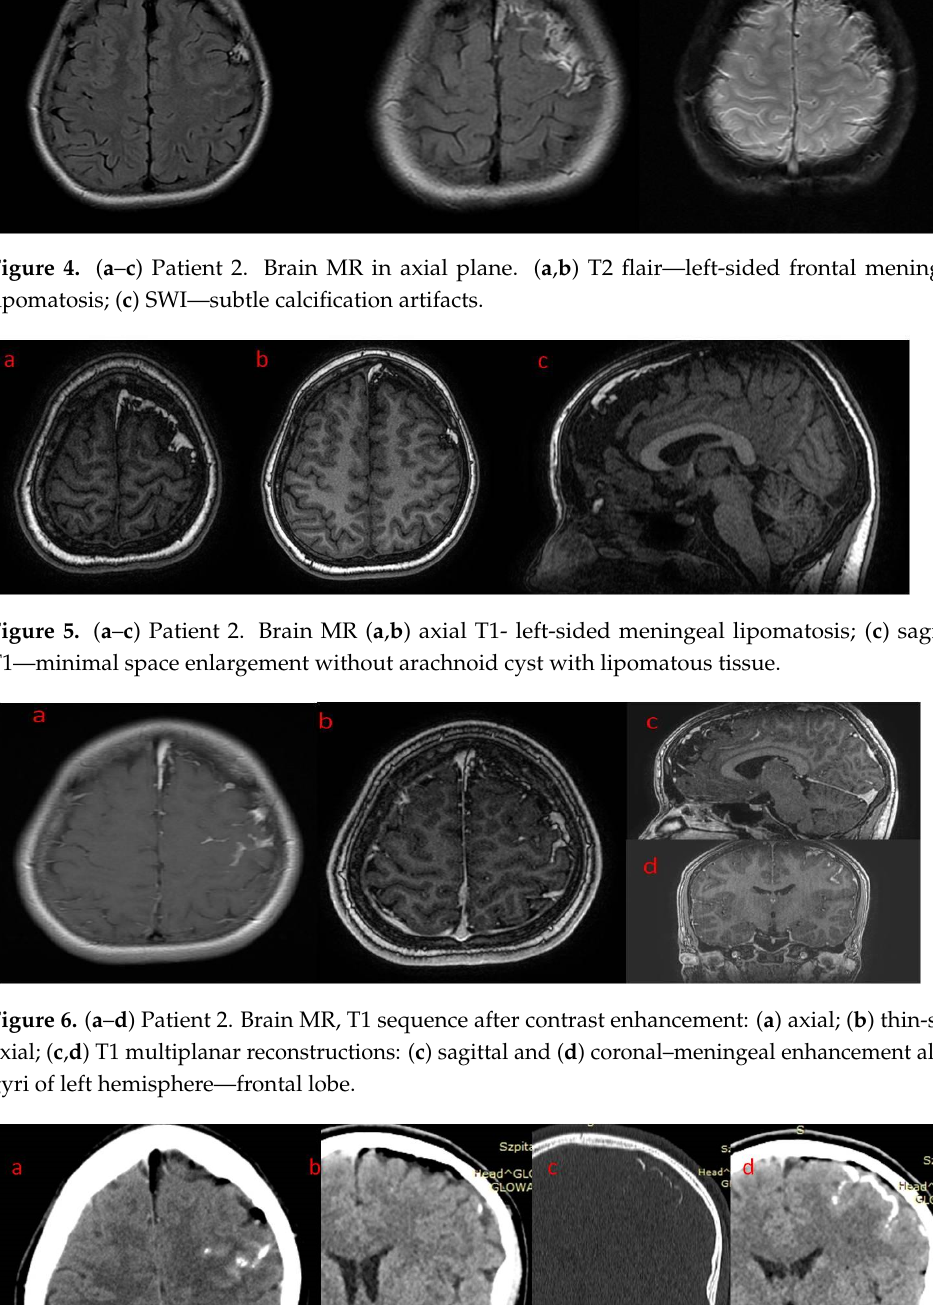
Figure 3. ( a – c ) Patient 1. Brain CT—left parietal and temporal gyral calcifications. ( a , b ) CT in axial brain window and coronal reformatted bone window; ( c ) MRI SWI sensitive to calcium/blood metabolites.